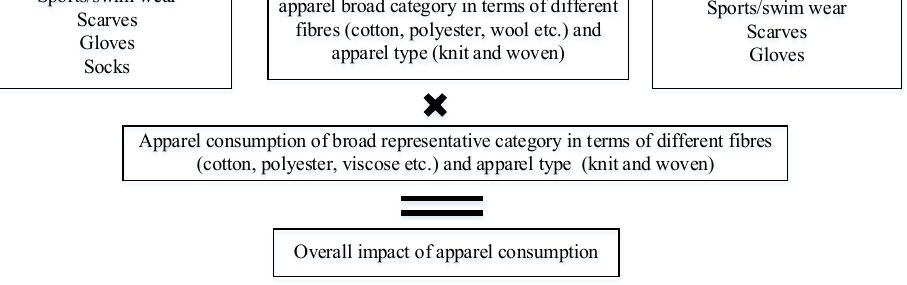
Fig. 3. Scale up environmental impact at the national